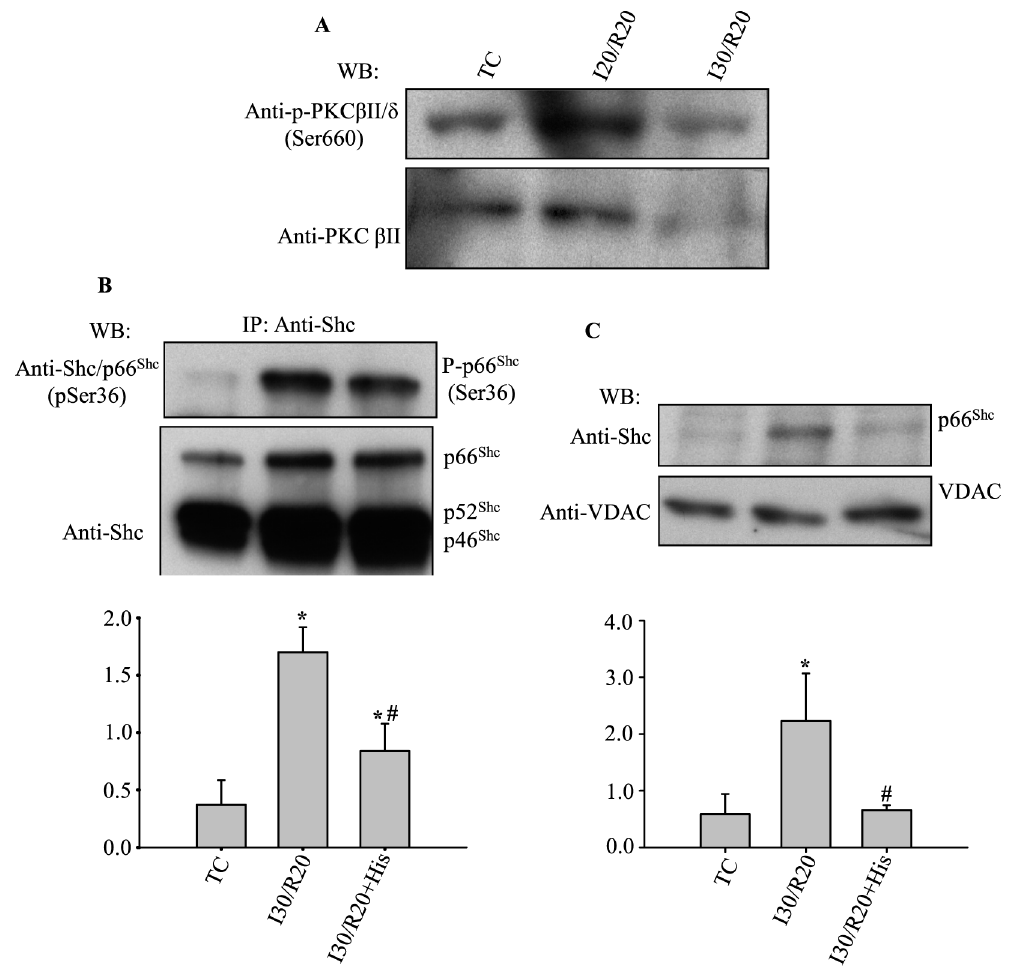
Figure 6. IR-induced activation of p66 Shc occurred via the PKC b II signaling pathway. A : Representative WB of 3 independent experiments of phosphorylation of PKC b II. B : Phosphorylation of p66 Shc at Ser36 during IR with or without hispidin (His) treatment. C : p66 Shc accumulation in mitochondria during IR with or without hispidin (His) treatment. B, C Lower panels show summary of mean band intensities derived from three independent experiments (n 5 3 hearts/group) (see Fig. 1 for imaging). P , 0.05: *IR vs. TC; # IR + His vs.